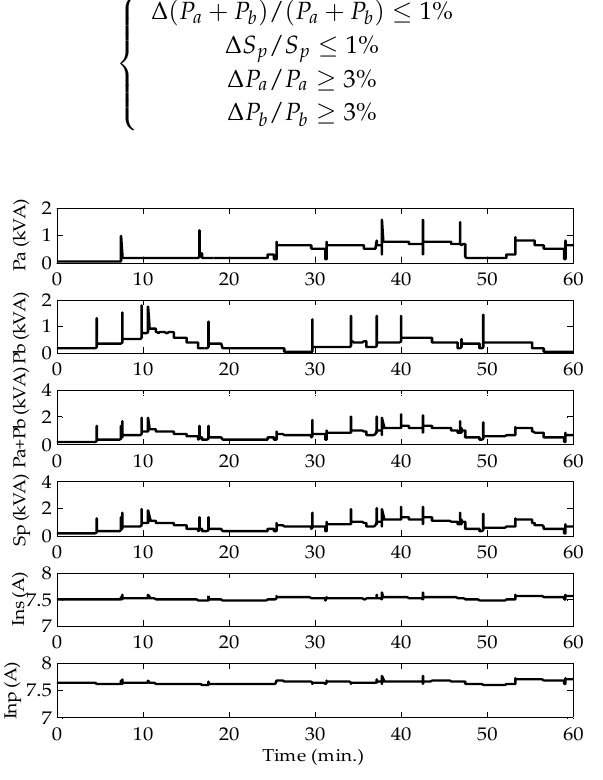
Figure 10. The powers and neutral currents of the transformer under normal operating conditions.